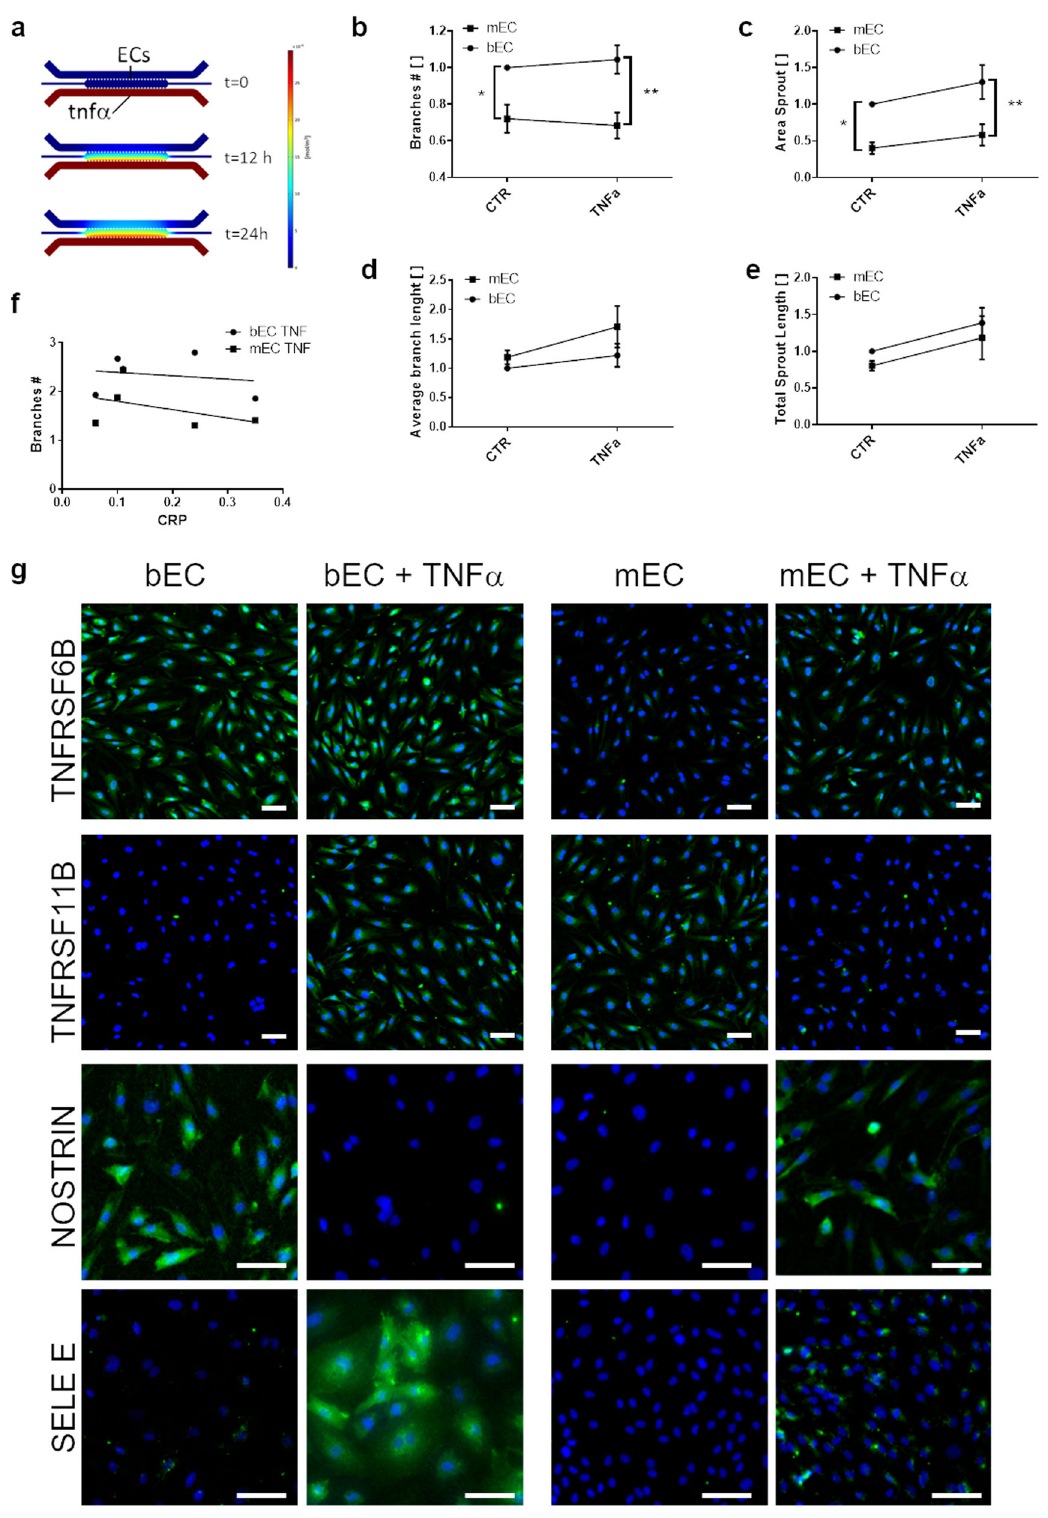
Fig. 4 angiogenic behavior and marker expression of bECs and mECs under TNF α stimulation. a Results of the computational simulation showing the establishment of a stable gradient of TNF α after 24 h of culture in the chip. Graphs comparing values of b branches number, c area sprouting, d average branch length and e total sprout length for bECs and mECs in control conditions and under stimulation with TNF α . Data were normalized on the value of bECs in control conditions, which was set at 1 ( n = 5, * p < 0.05; ** p < 0.01). Average and SEM of at least 5 replicates per patient are shown. f Interpolation of the branch number plotted against CRP values, for mECs and bECs under TNF α stimulation, showing no correlation. g Immuno fl uorescence staining of bECs and mECs in control conditions or stimulated with TNF α . Green staining represents the protein (TNFRSF6b, TNFRSF11, NOSTRIN, SELE-E), nuclei in blue (DAPI). Scale bars 50 µ